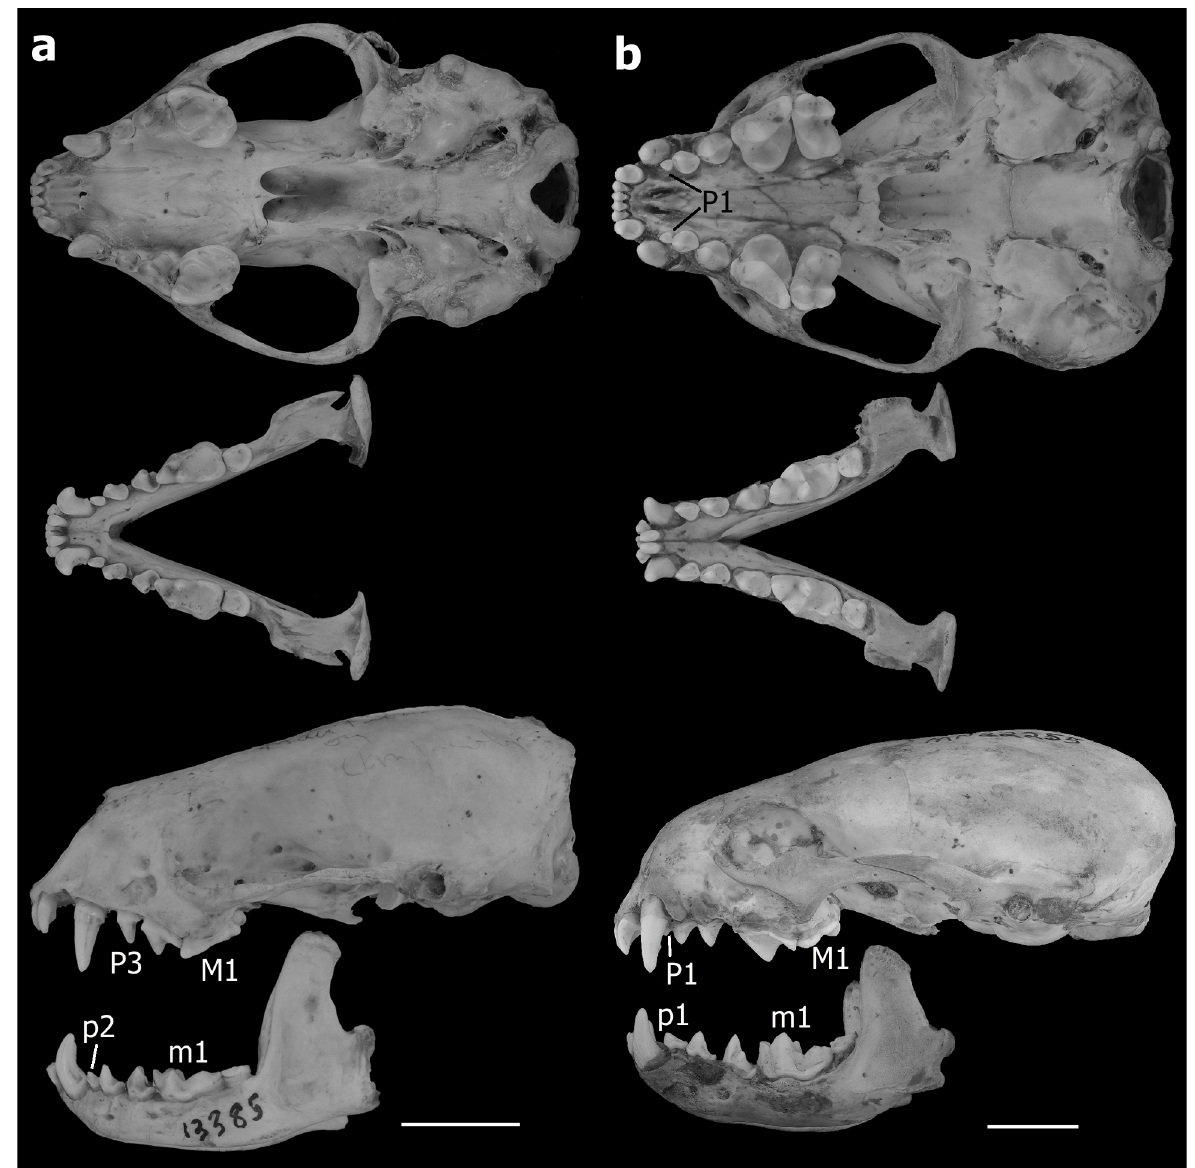
Figure 4. Occlusal (top) and lateral (bottom) views of the skull and mandible of: a) Conepatus semistriatus (MN13385); b) Lontra longicaudis (MN22255). Abbreviation “P” means premolars and “M” molars. Scale bar =